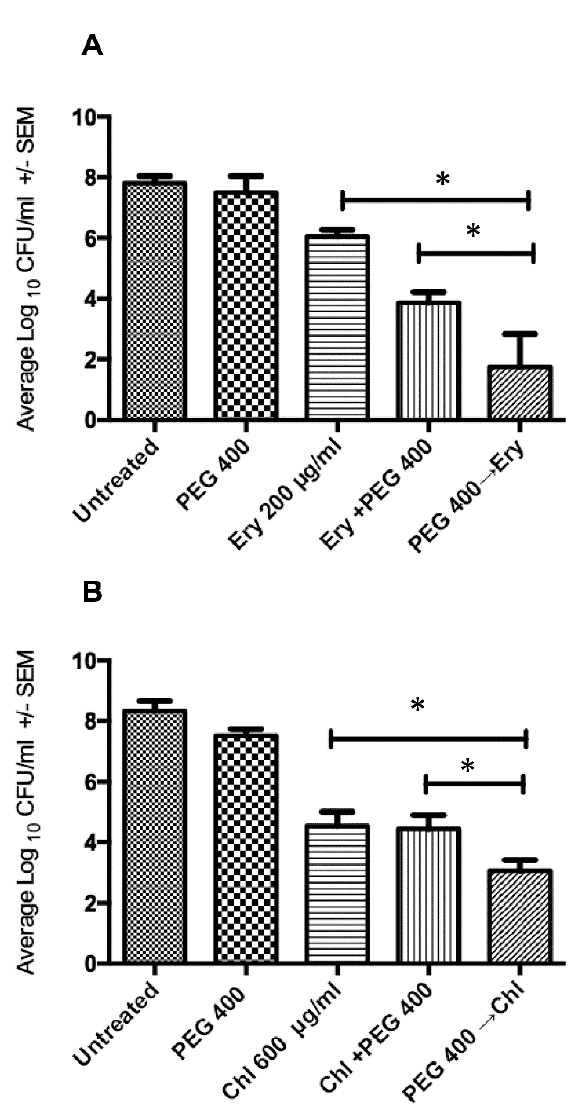
Figure 3. Treatment of Acinetobacter baumannii biofilms with individual, combined ( + ) or sequential ( → ) treatment of osmotic compound polyethylene glycol (PEG 400) followed by ( A ) erythromycin (Ery, 200 µ g / mL) or ( B ) chloramphenicol (Chl 600 µ g / mL). Three biological replicates were used to calculate the error bars that represent the standard error of the means (* p <